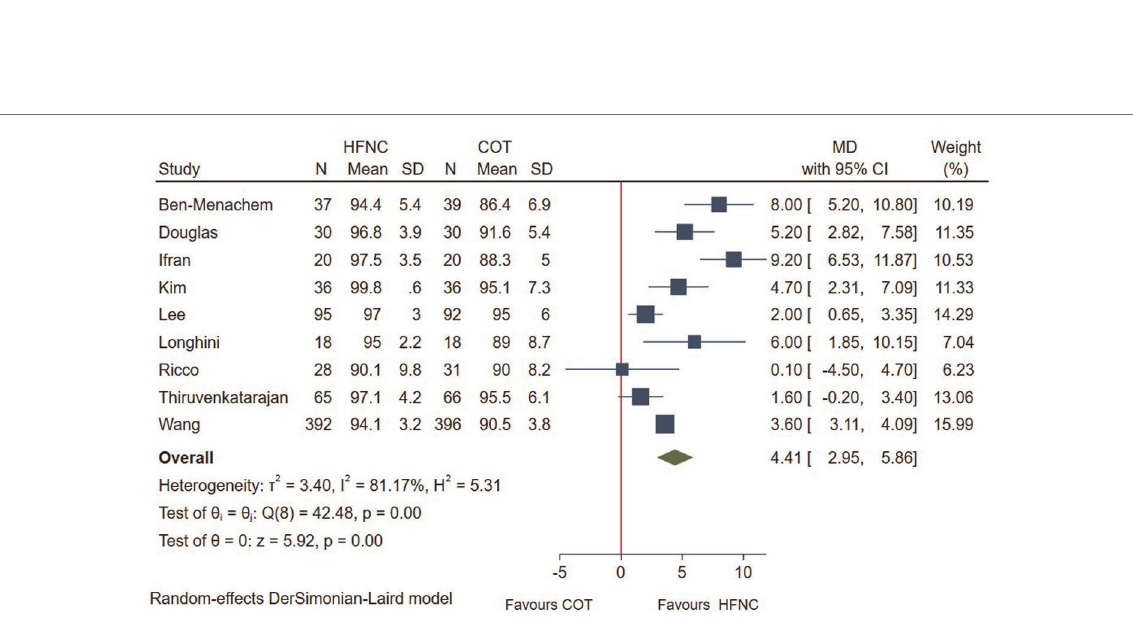
FIGURE 3 Forest plot comparing lowest SpO2 during the procedure in HFNC versus COT. HFNC, high fl ow nasal cannula; COT, conventional oxygen therapy; MD, mean